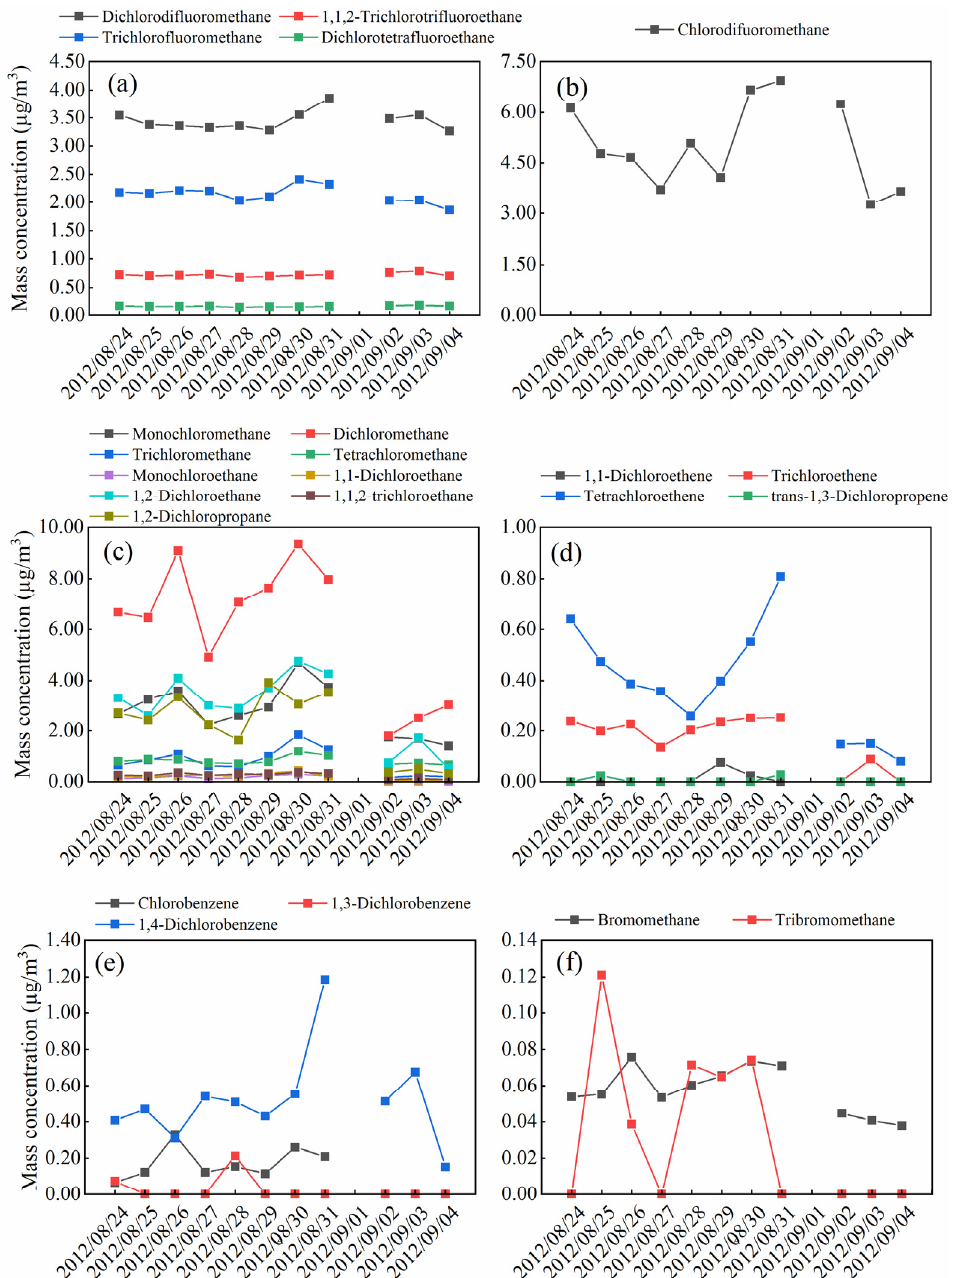
Figure 6. Daily variation in average mass concentration of selected volatile halogenated halocarbons. ( a ): chlorofluorocarbons; ( b ): hydrochlorofluorocarbon; ( c ): chloroalkanes; ( d ): chloroalkenes; ( e ): chlorinated benzenes; ( f ): bromohydrocarbons.